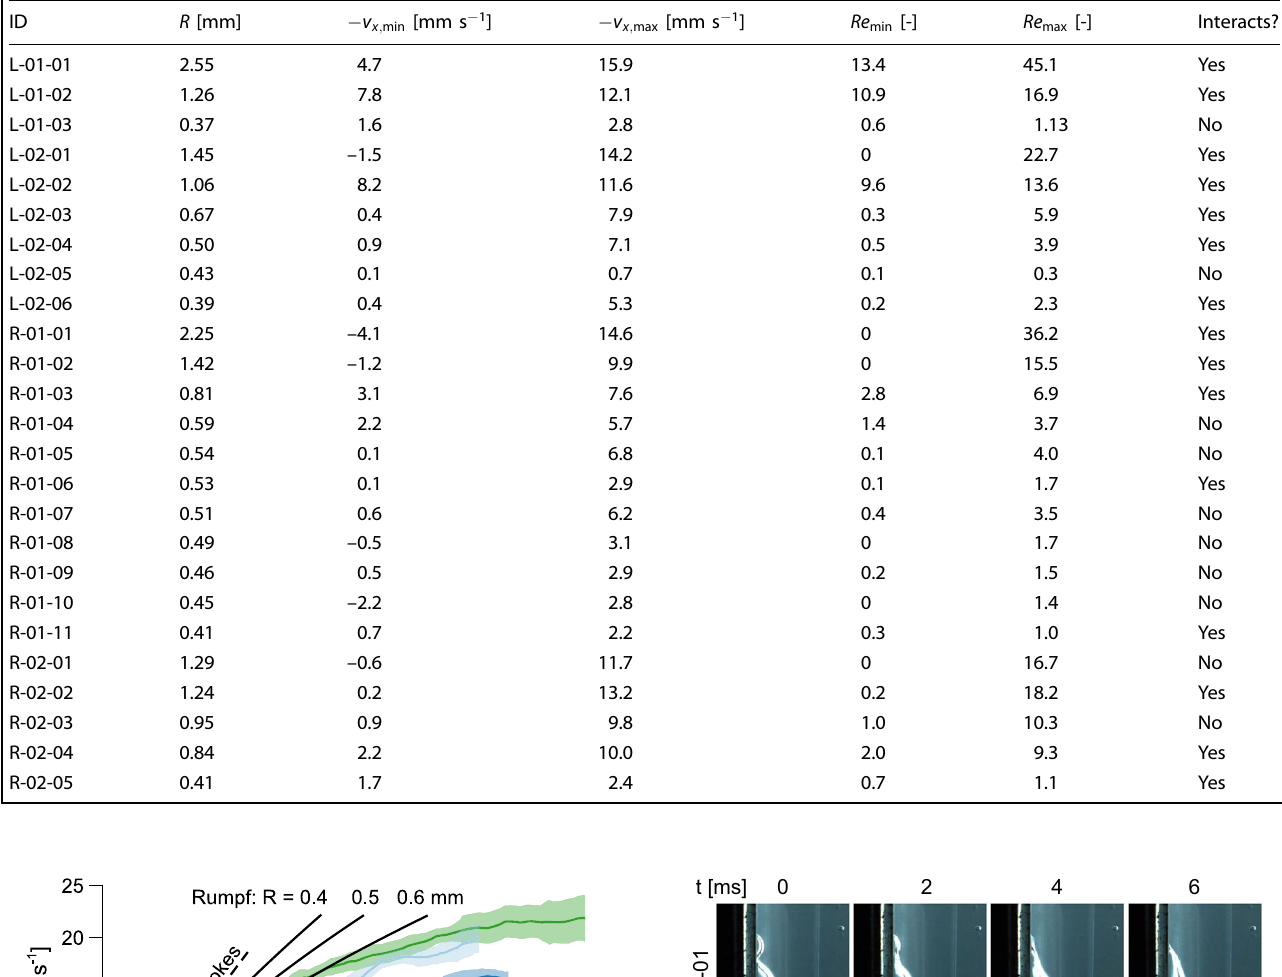
Table 2. Bubbles tracked during 4.7 s of free fall. A unique label is assigned to each bubble for the L-01, L-02, R-01, and R-02 experiments.